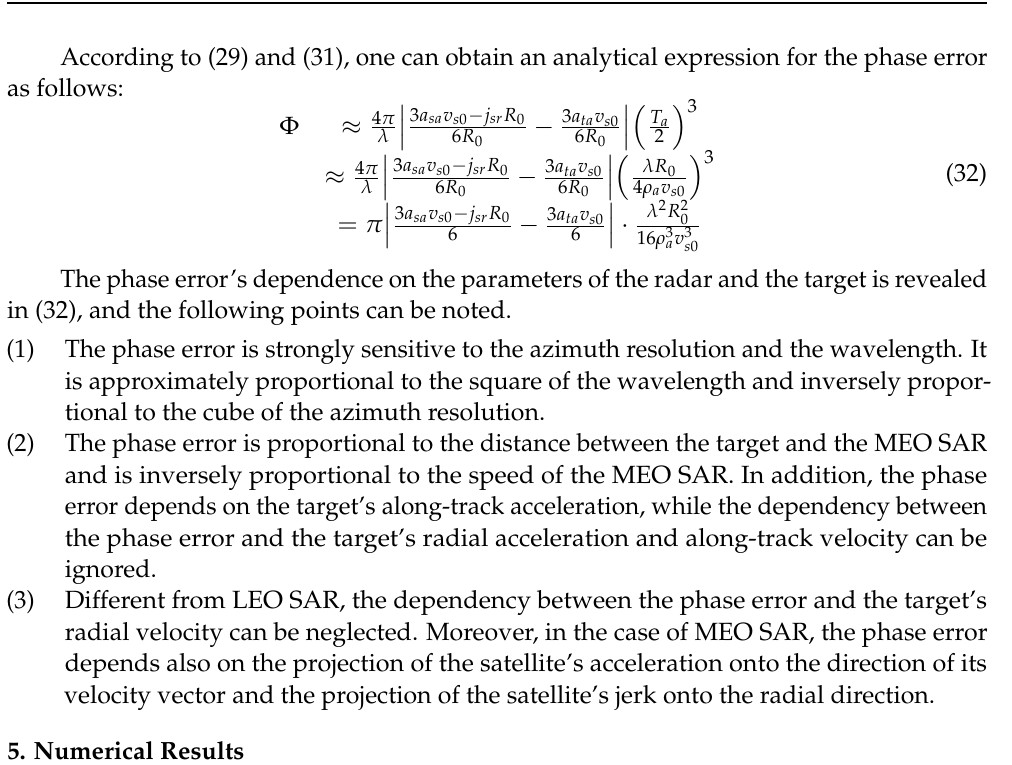
Table 1. Orbit parameters for the numerical simulations. Parameter Value Height of the orbit 10,000 km Radius of the Earth 6371 km Right ascension of ascending node 0 Argument of perigee 0 Orbit inclination 90 ◦ Eccentricity 0 Greenwich hour angle at t a = 0